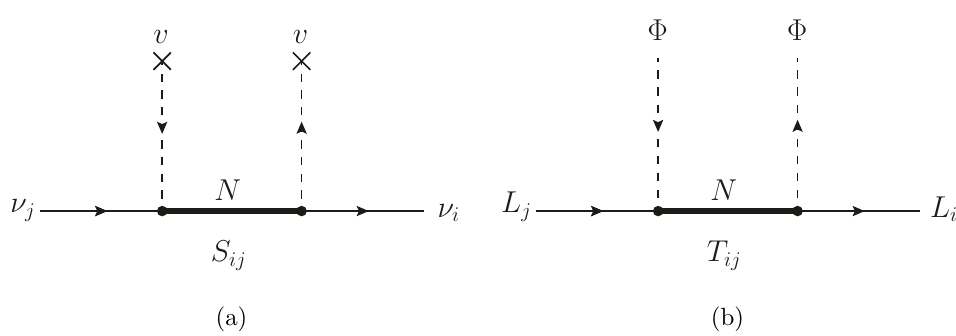
Figure 1. (a) Diagrammatic representation of the mass insertion S ij in the broken theory (see eq. (2.16)). ν and ν are SM-like left-handed neutrino gauge eigenstates, which can also interact i j with the SM gauge bosons, whereas N is the right-handed neutrino, which is a singlet under the SM gauge group. The dashed lines indicate the insertions of the Higgs vev v . (b) The related object, T ij , defined in eq. (2.17), which is relevant in the unbroken theory and enters the SMEFT matching relations. Here L and L are SM lepton doublets. N is the right-handed neutrino. i j